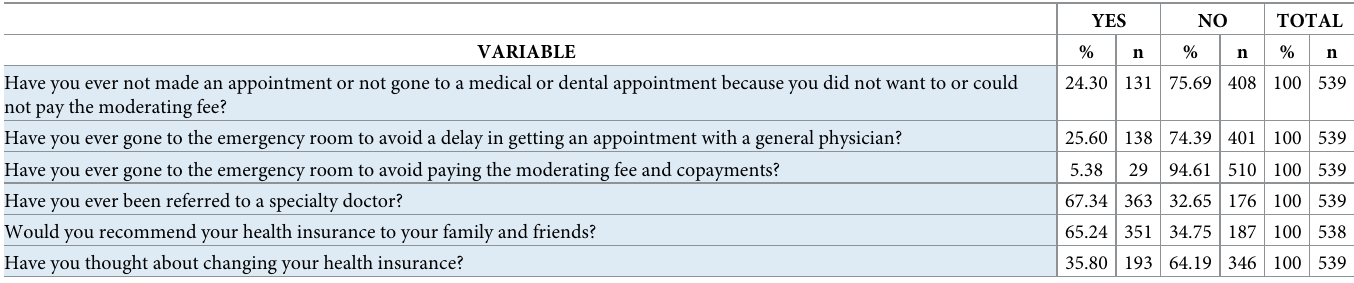
Table 1. Perception of barriers to access to health services.